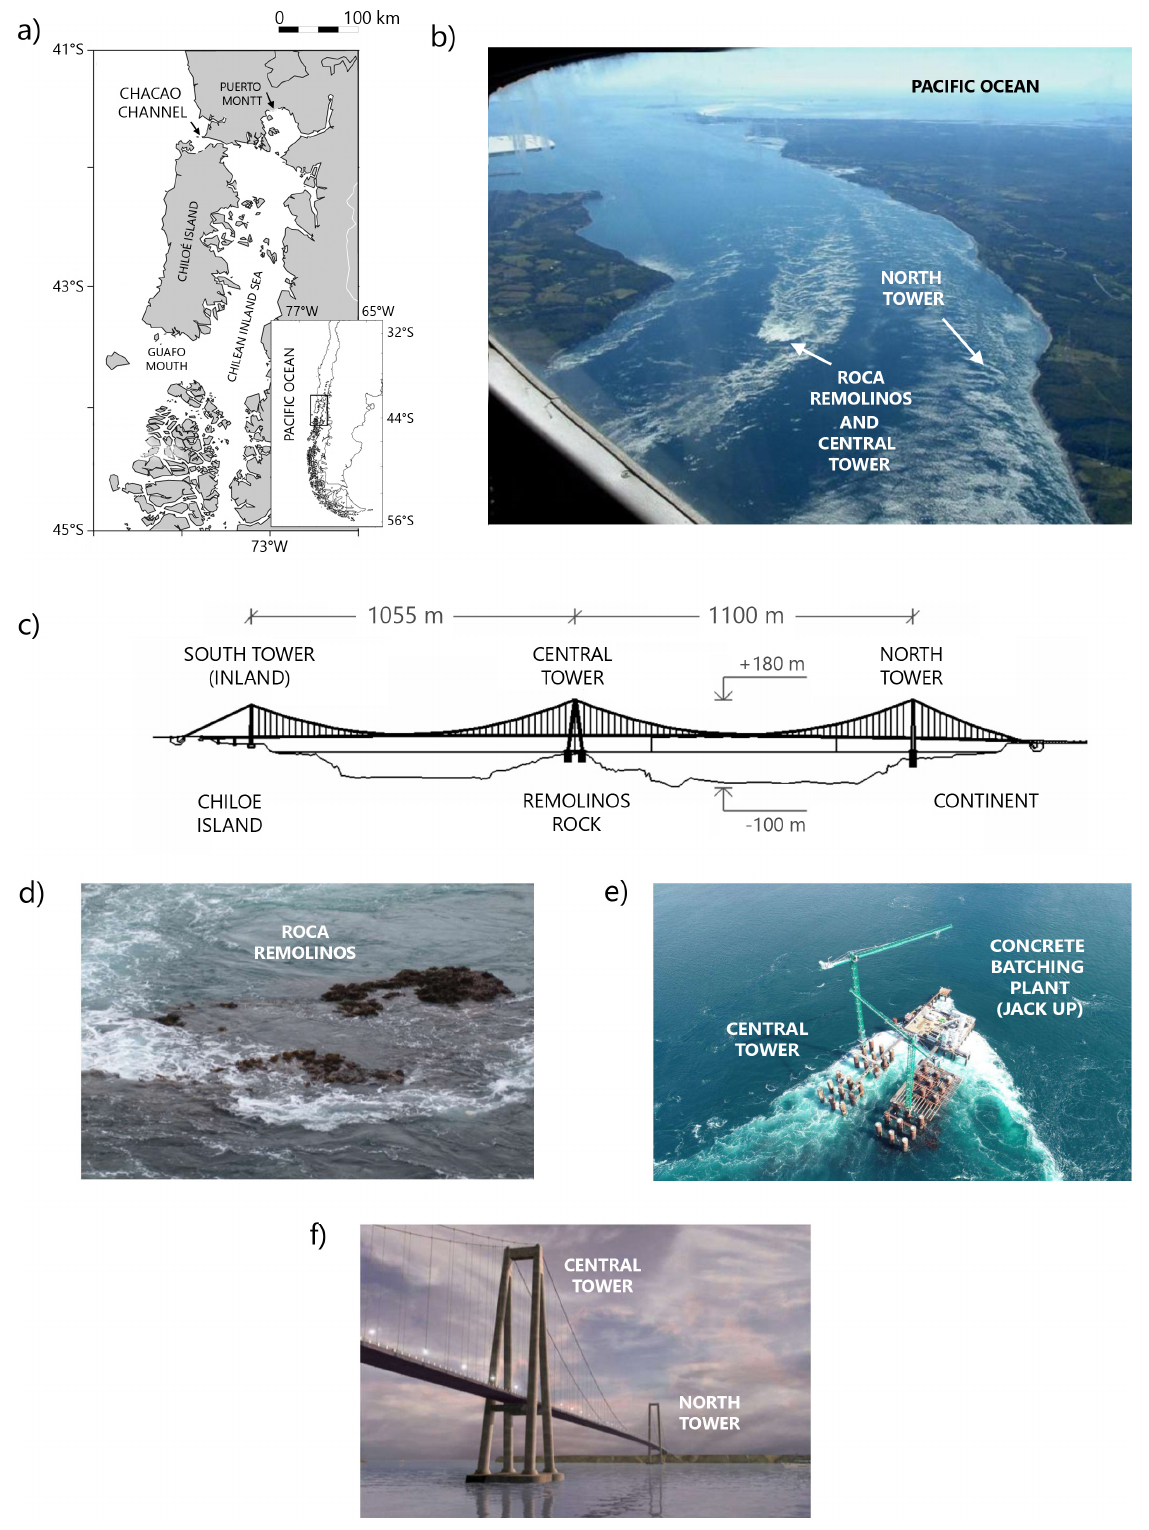
Figure 1. ( a ) Map showing Chacao Channel, Chiloé Island and the Chilean Inland Sea. ( b ) Aerial view of the narrowest section of Chacao Channel during ebb tide. Remolinos Rock generates a turbulent wake (courtesy of Horacio Parrague). ( c ) A frontal view of the bridge showing the position of Central and North towers. ( d ) A close view of Remolinos rock. ( e ) A current view of bridge piers being mounted over Remolinos rock site. ( f ) A projected view of the